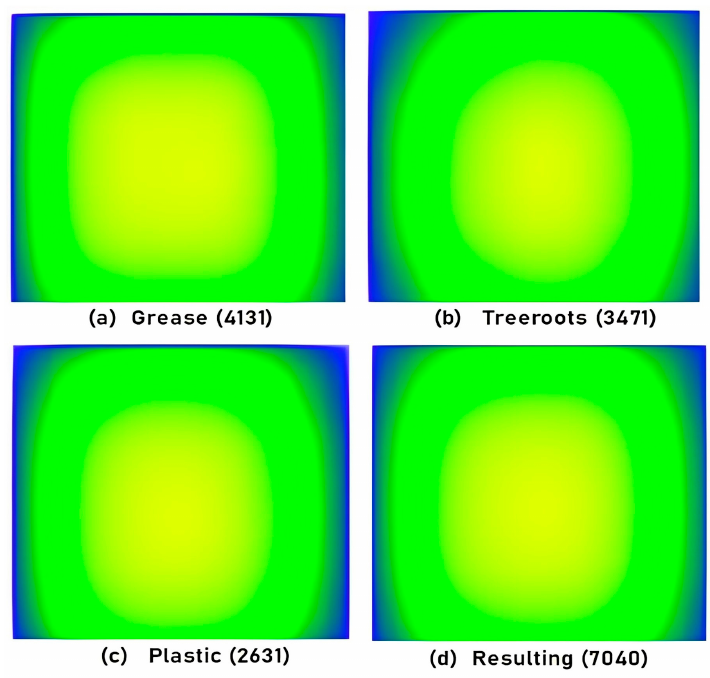
Figure 9. Annotation heatmap details for captured frames. The imagery data is balanced into three groups such as training data with 4928 frames (70%), validation data with 1408 frames (20%) and testing data with 704 frames (10%) as shown in Figure 10.